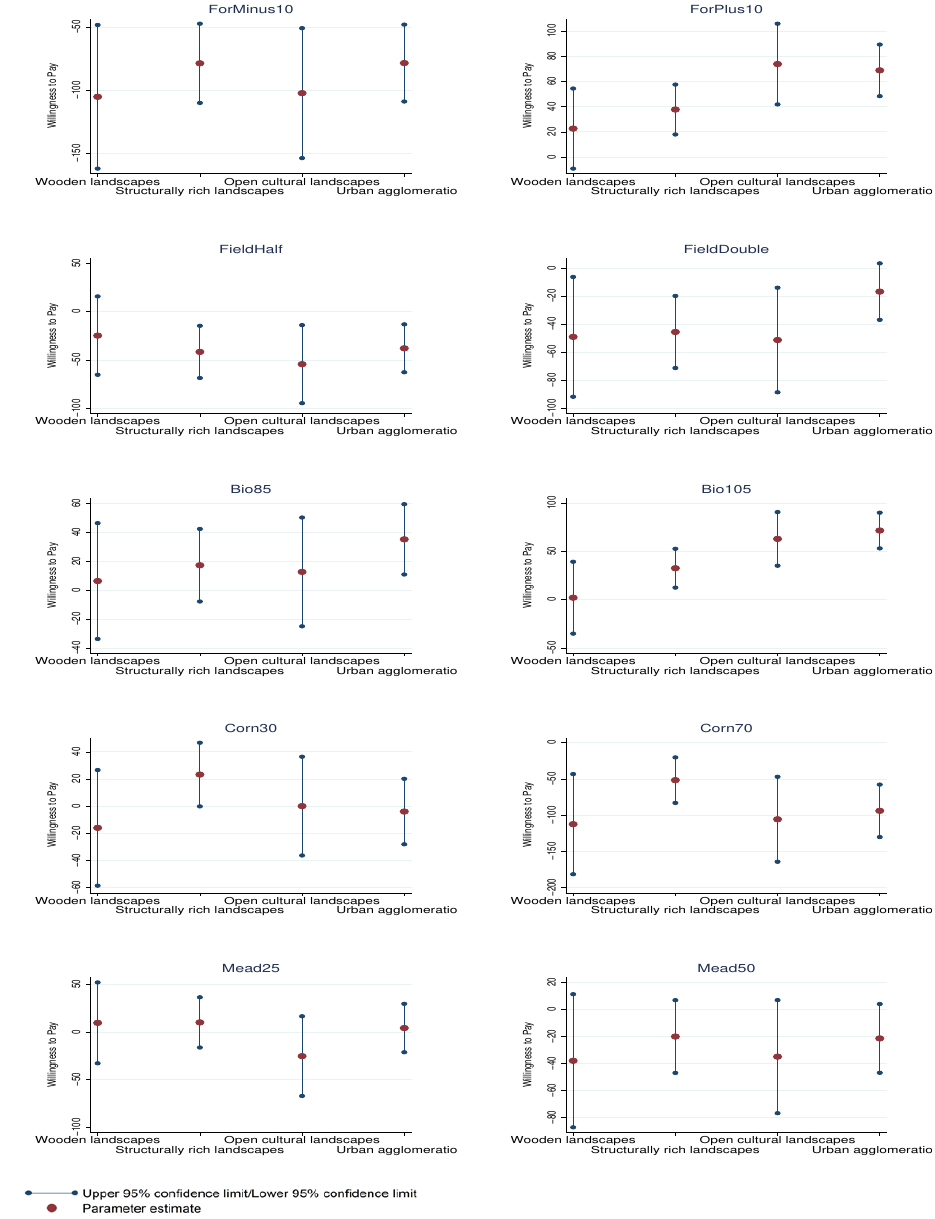
Figure 3. Willingness to pay confidence intervals by sample.